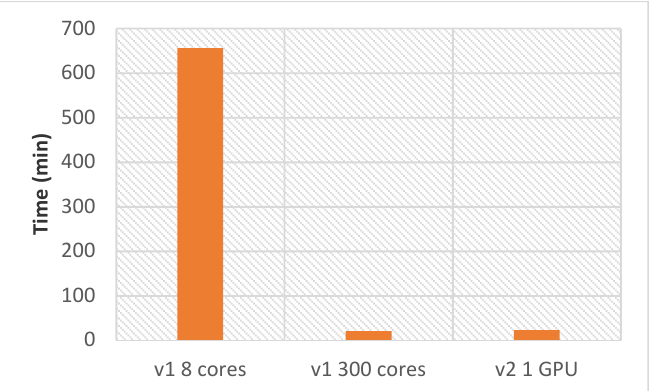
Figure 3. Comparison of the calculation time between the two AMIDE versions. Data were graphed for ligand (4) docked on the T. gondii dataset (87 proteins). The use of a personal PC was represented through the consideration of 8 cores and 1 GPU in the case of AMIDE v1 and AMIDE v2, respectively. The calculation time obtained with AMIDE v1 became as good as the one obtained with AMIDE v2 using 300 cores. The number of docking experiments per box was equal to 20.